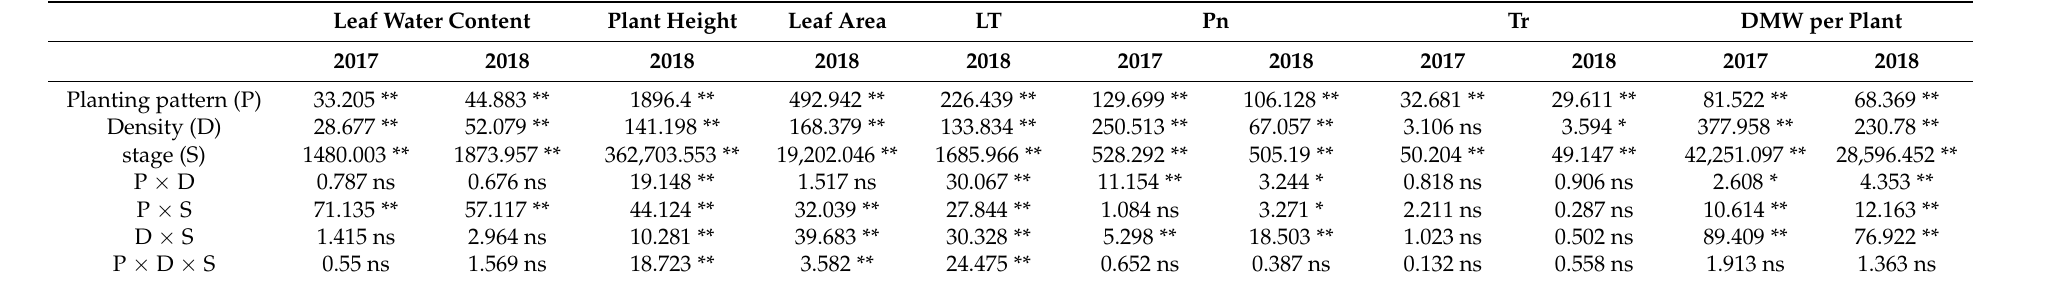
Table 1. The F value of the statistical analysis.